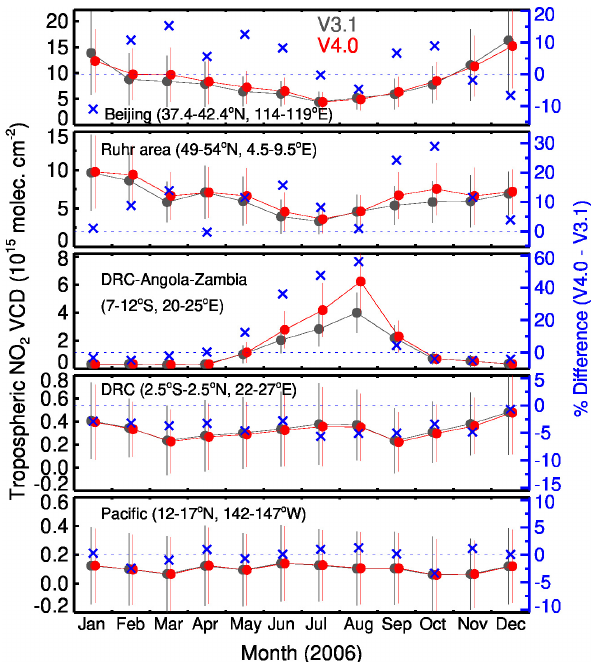
Figure 11. Monthly average tropospheric NO 2 columns in 2006 calculated from V3.1 (black) and V4.0 (red) data over selected 5 ◦ latitude × 5 ◦ longitude boxes from locations that are dominated by either anthropogenic (Beijing, China, and the Ruhr area, Ger- many), biomass burning (Democratic Republic of Congo – DRC, Angola, and Zambia), lightning (DRC), or no significant (Pacific) NO x sources. The vertical bars show the monthly standard devia- tion. The blue symbols that correspond to the right y axis show the monthly relative difference (in percent) between V4.0 and V3.1.